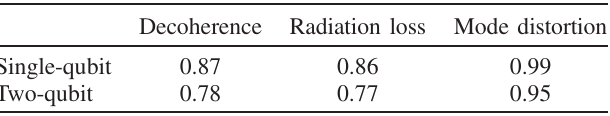
FIG. 4. Measured process maps with χ (a) the identity, (b) the X gate, (c) the Y gate, (d) the T gate, and (e) the controlled-phase ( CPHASE ) gate. For comparison, we also show (red wire frames) and ideal χ the simulated χ ffiffiffiffiffiffiffiffiffiffiffiffiffiffiffiffiffiffiffiffiffiffiffiffiffiffiffiffiffiffiffiffiffiffiffiffiffiffiffiffiffiffiffiffiffiffi sim p ffiffiffiffiffiffiffiffiffiffi p p χ χ Þ 2 and the internal fidelity F χ Tr ð meas ideal meas magnitude.